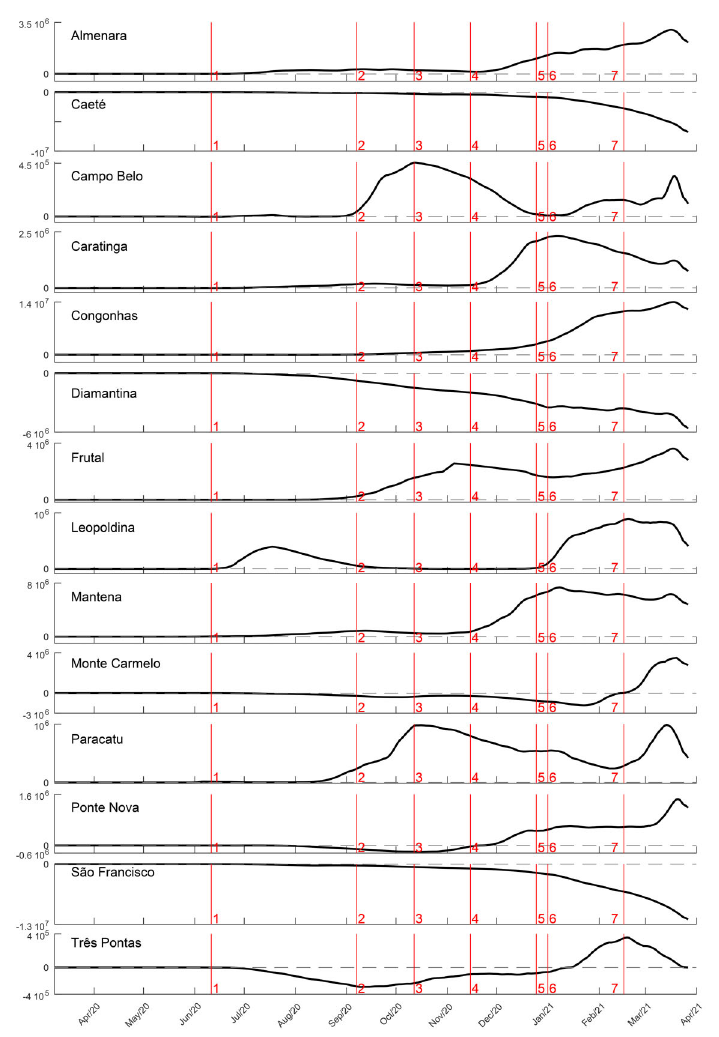
Figure 7. COVID-19 signed squared difference (SSD) time series for the 14 municipalities of Minas Gerais state macro-regions. The red vertical lines indicate the main Brazilian holidays: 1: Corpus Christi ; 2: Brazilian Independence Day; 3: Nossa Senhora